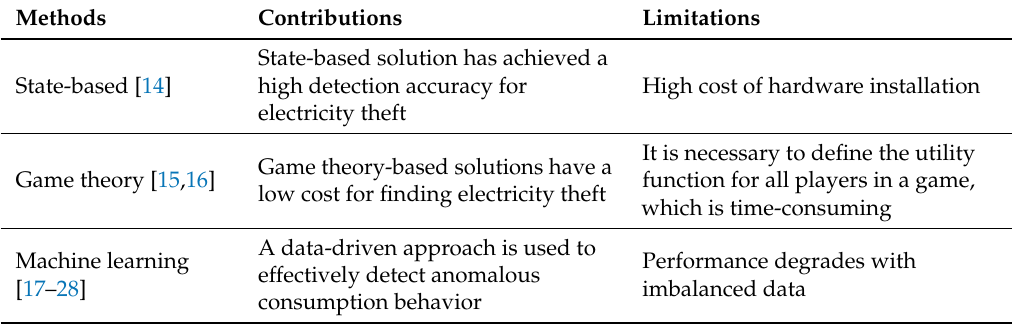
Table 2. Contributions and limitations of defense techniques against electricity